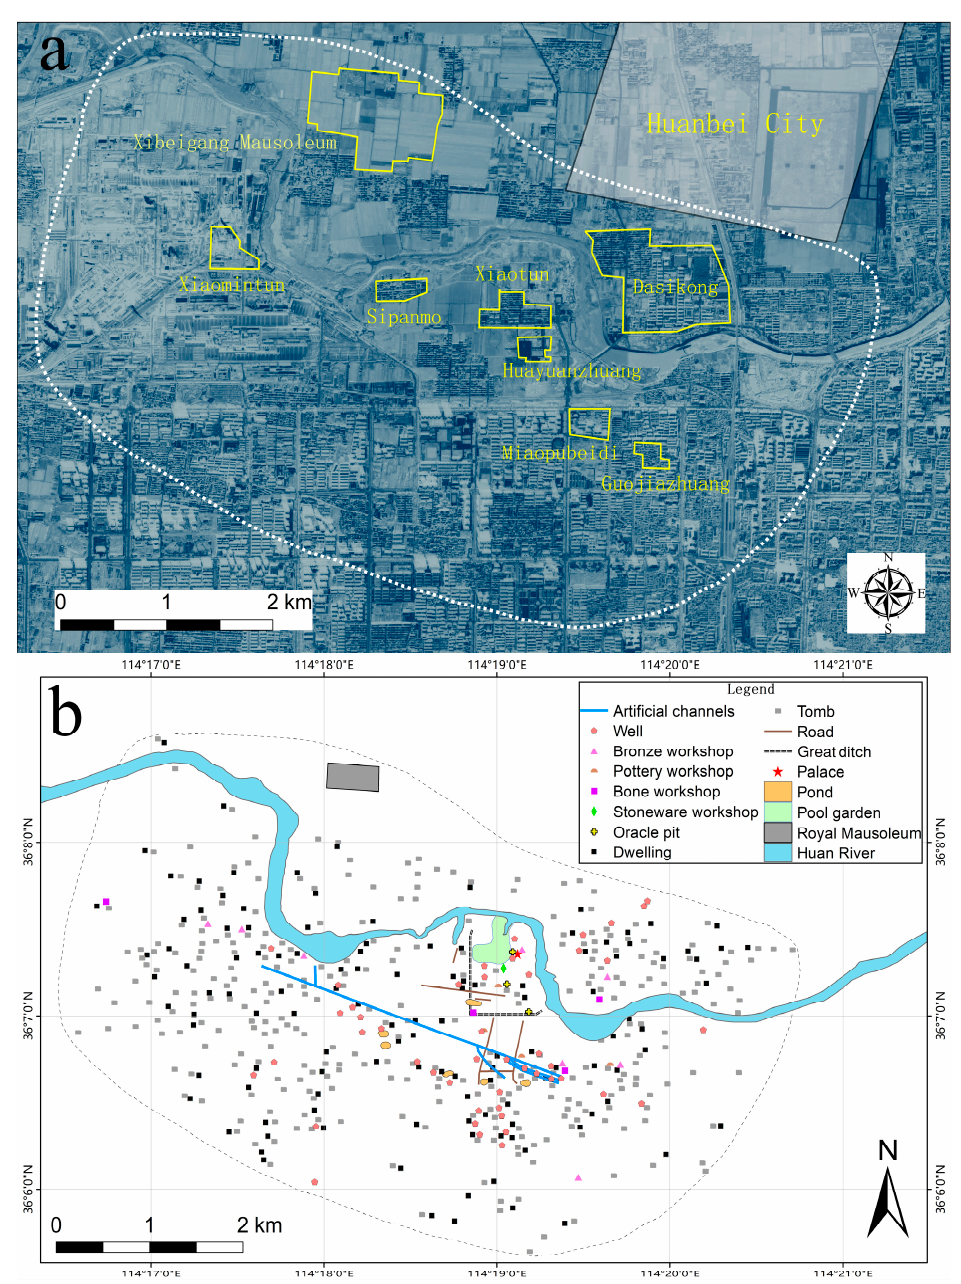
Figure 2. ( a ) Satellite image of Yinxu site area showing toponyms mentioned in this article; ( b ) vectorized map showing major archaeological features within Yinxu site